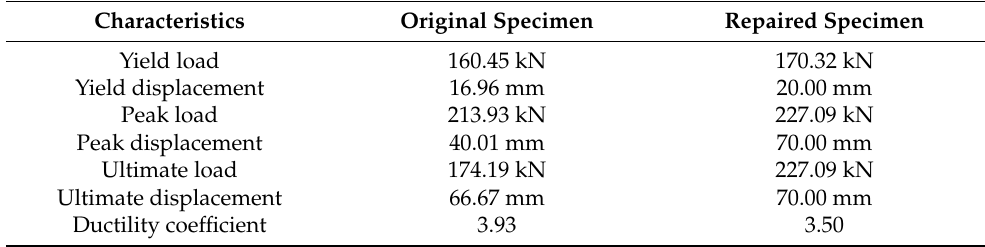
Table 4. Seismic performance characteristics for the specimens.